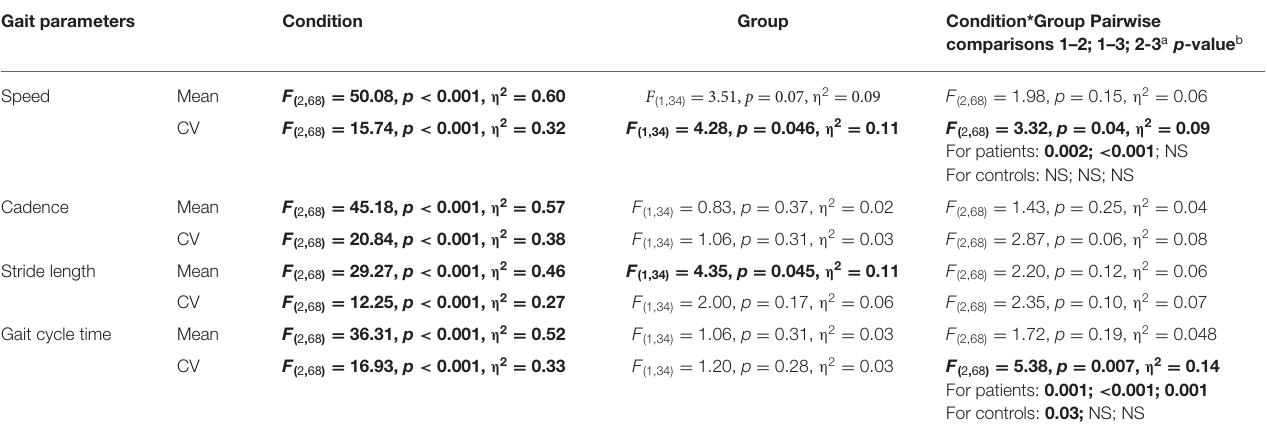
TABLE 2 | Repeated analyses of variance for gait parameters. Gait parameters